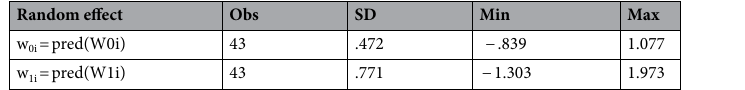
Table 2. Descriptive statistics for predicted random effects (no baseline obs.)